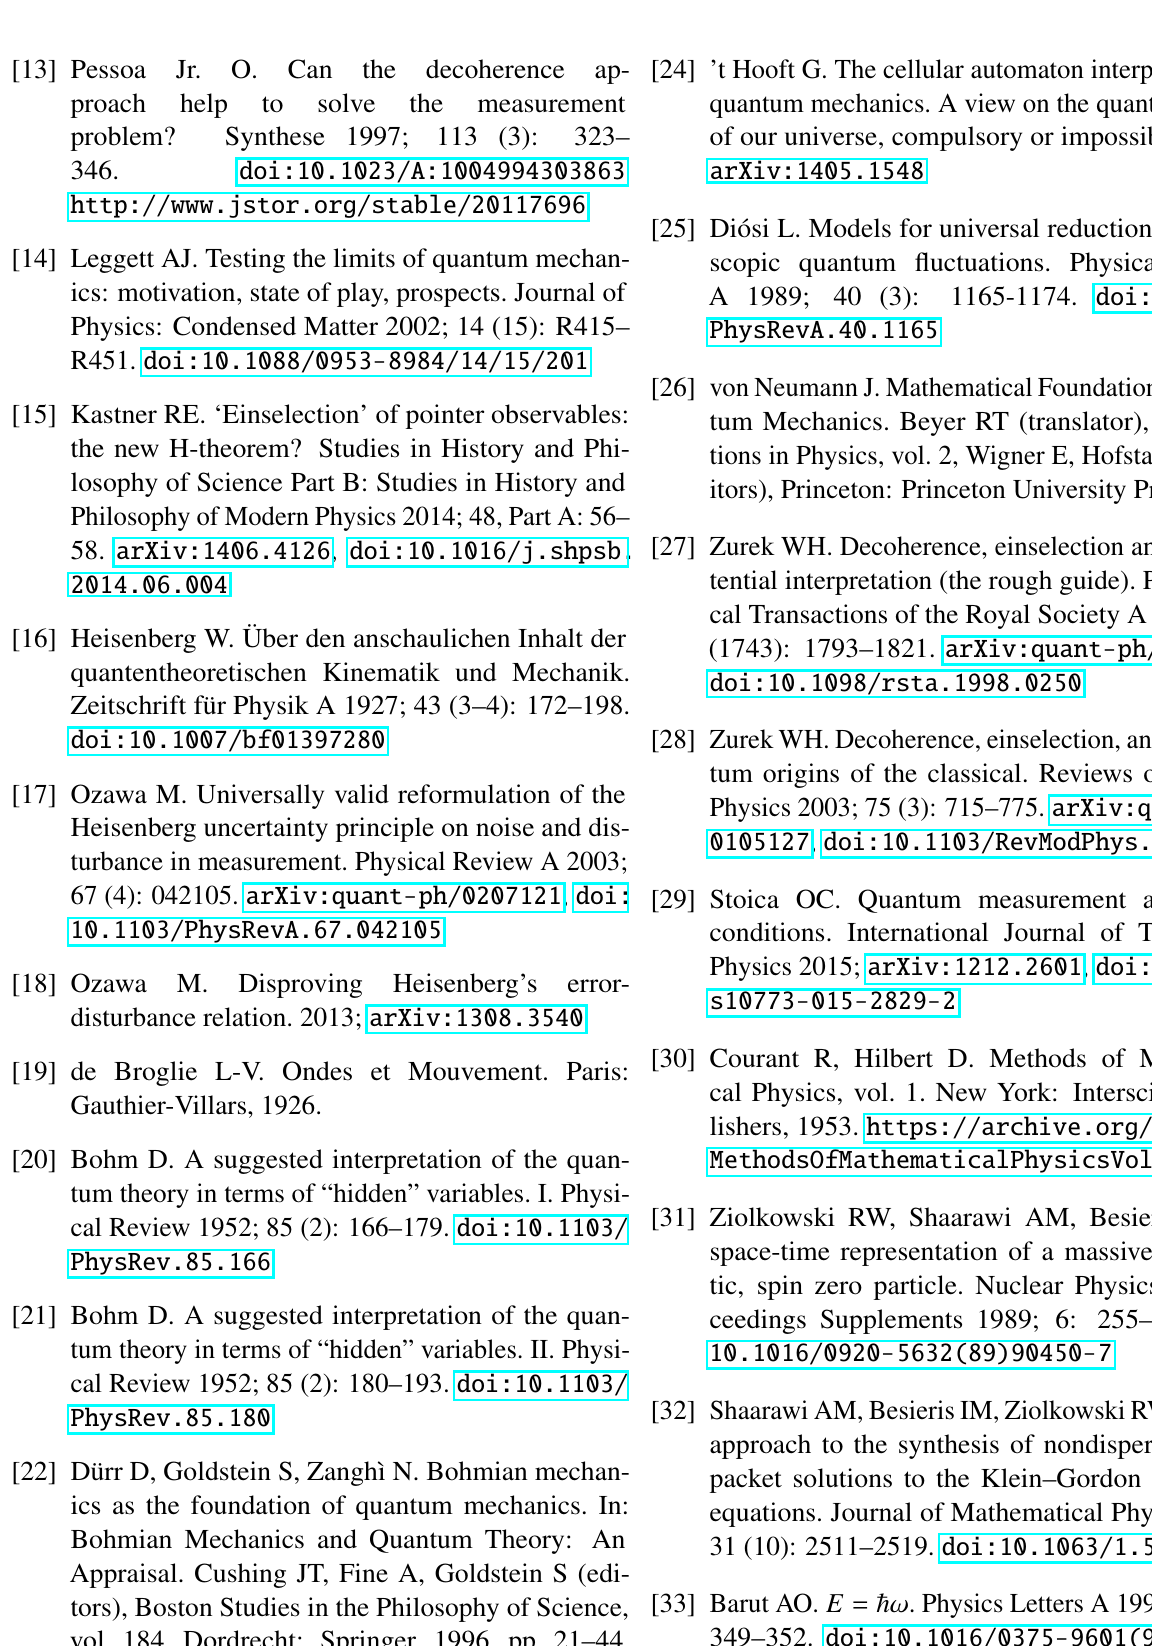
[34] Barut AO, Grant A. Quantum particle-like con- figurations of the electromagnetic field.